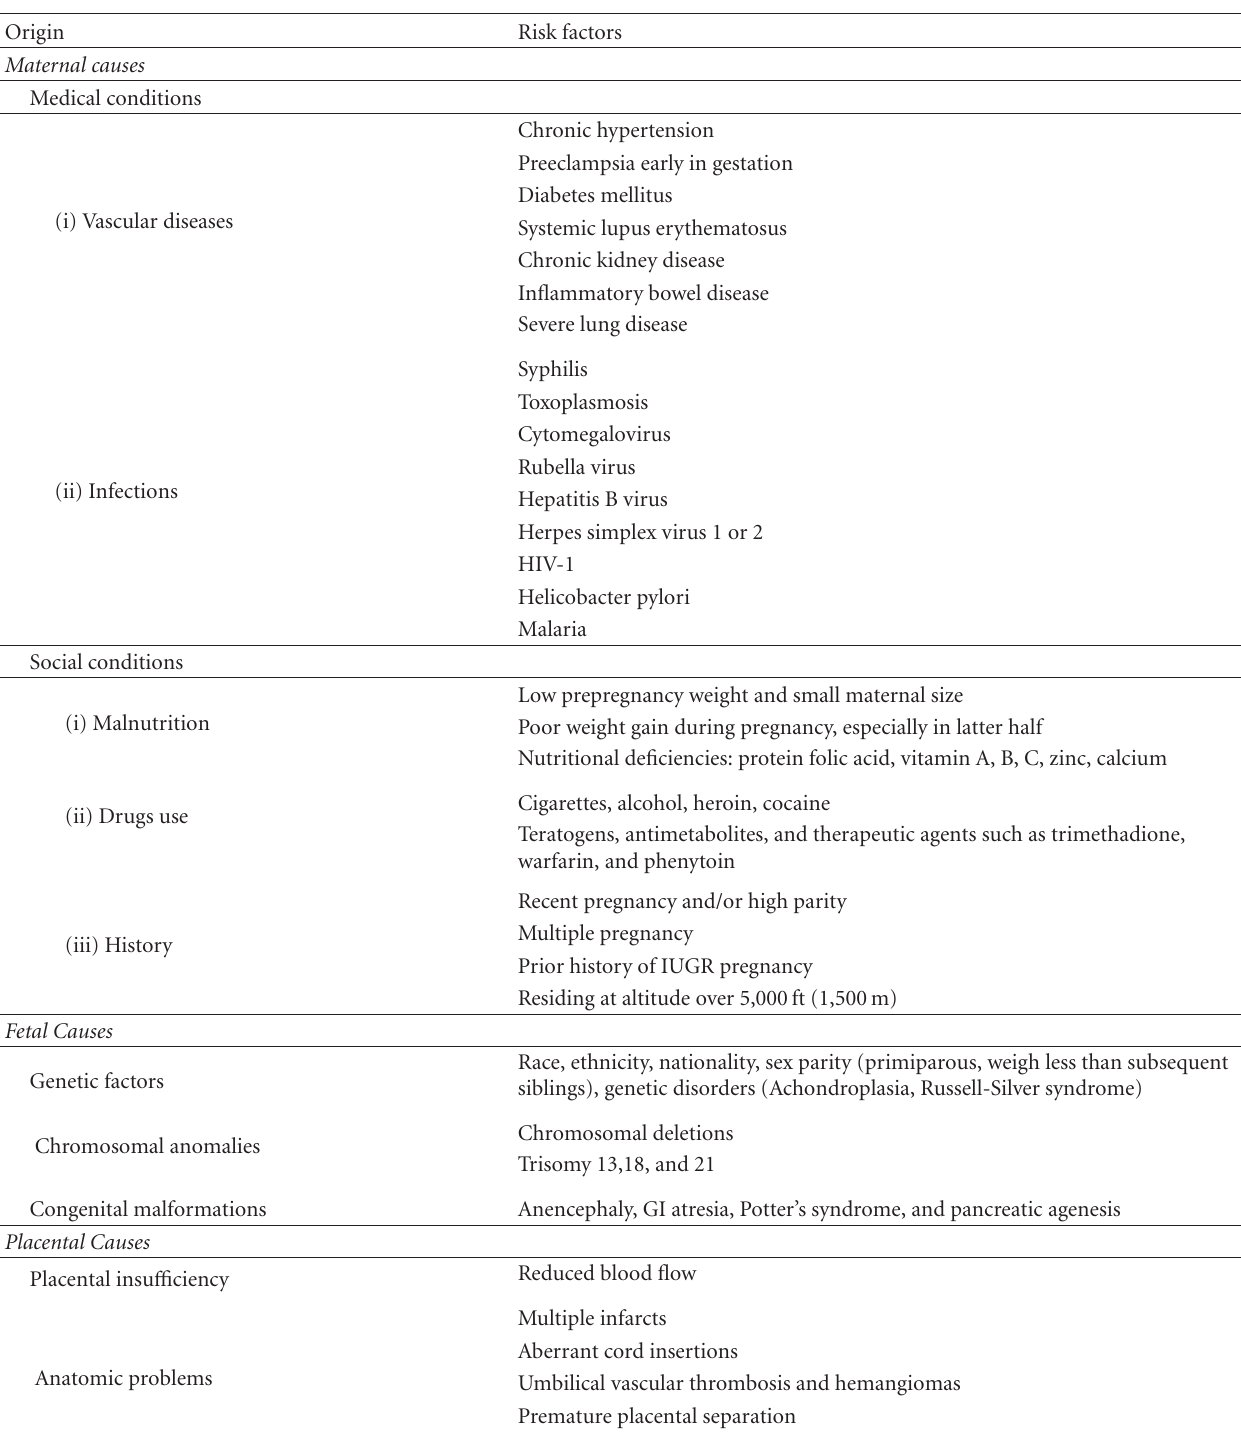
Table 1: Risk factors in